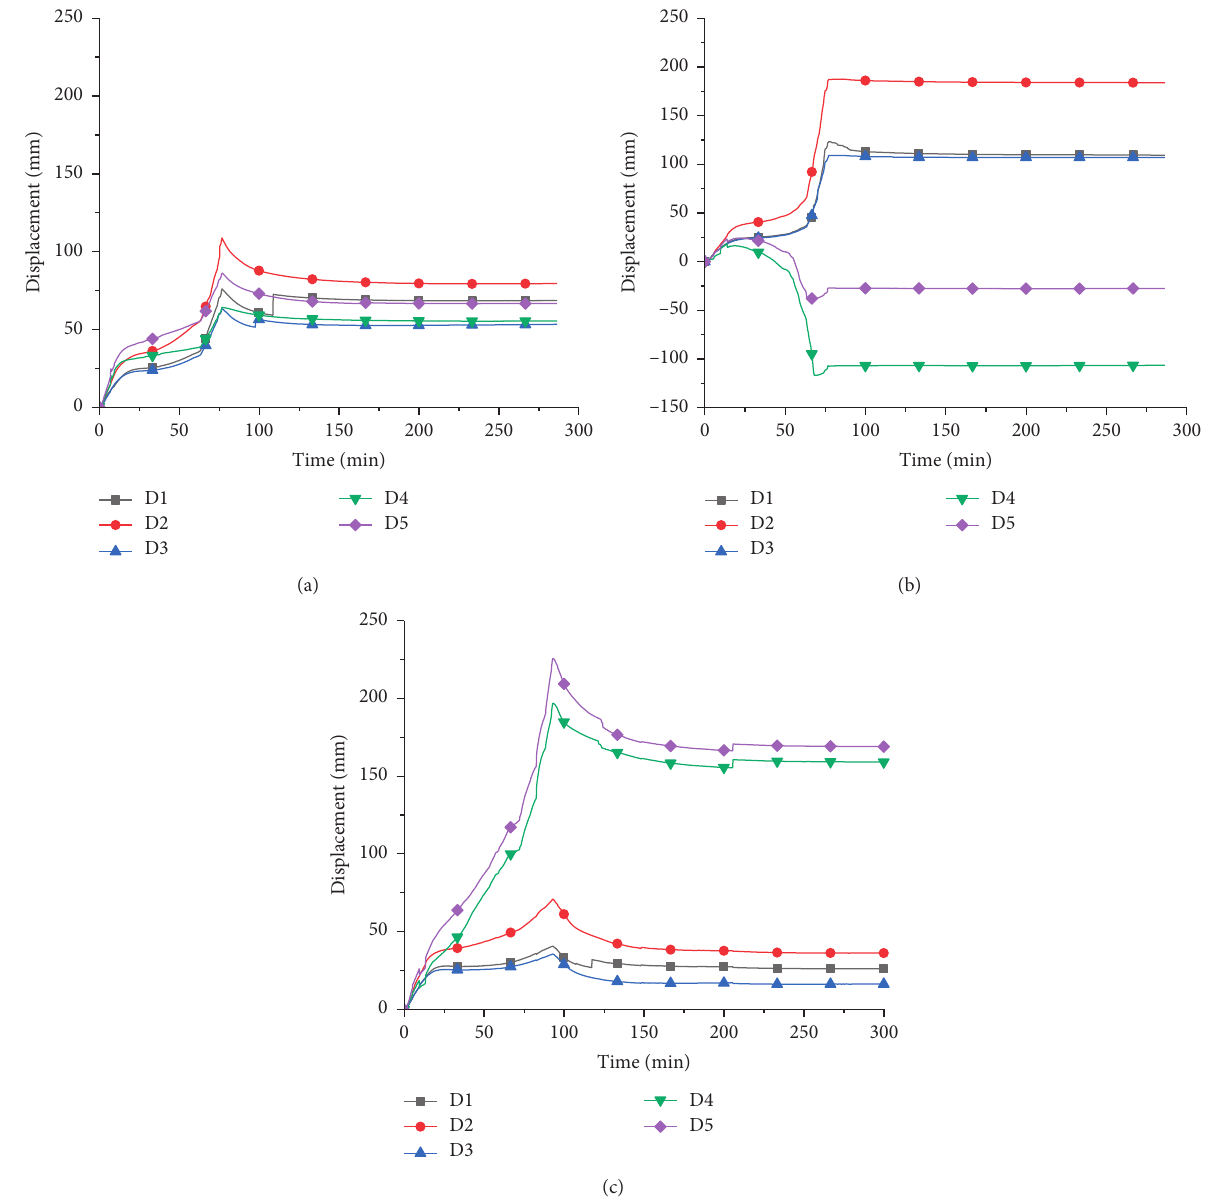
Figure 10: Displacement–time curves of (a) SCB-1, (b) SCB-2, and (c)